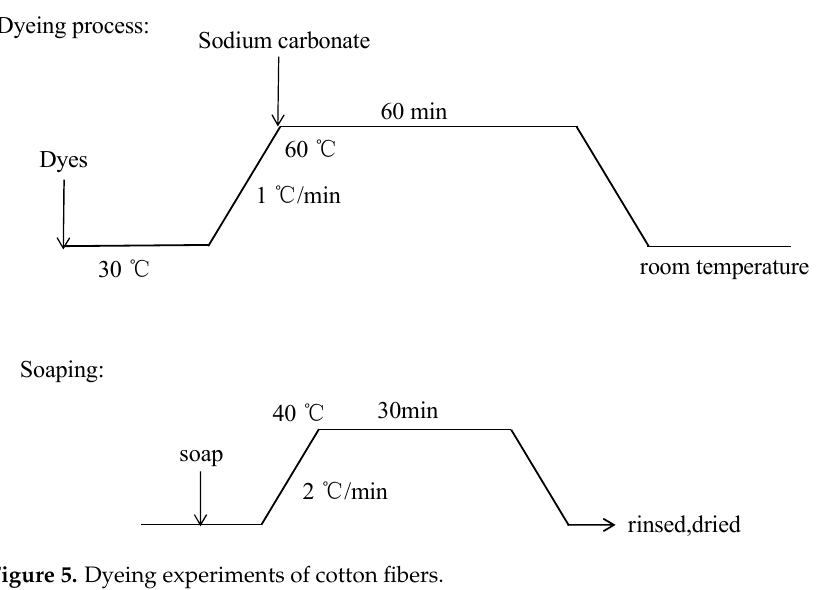
Figure 5. Dyeing experiments of cotton fibers.